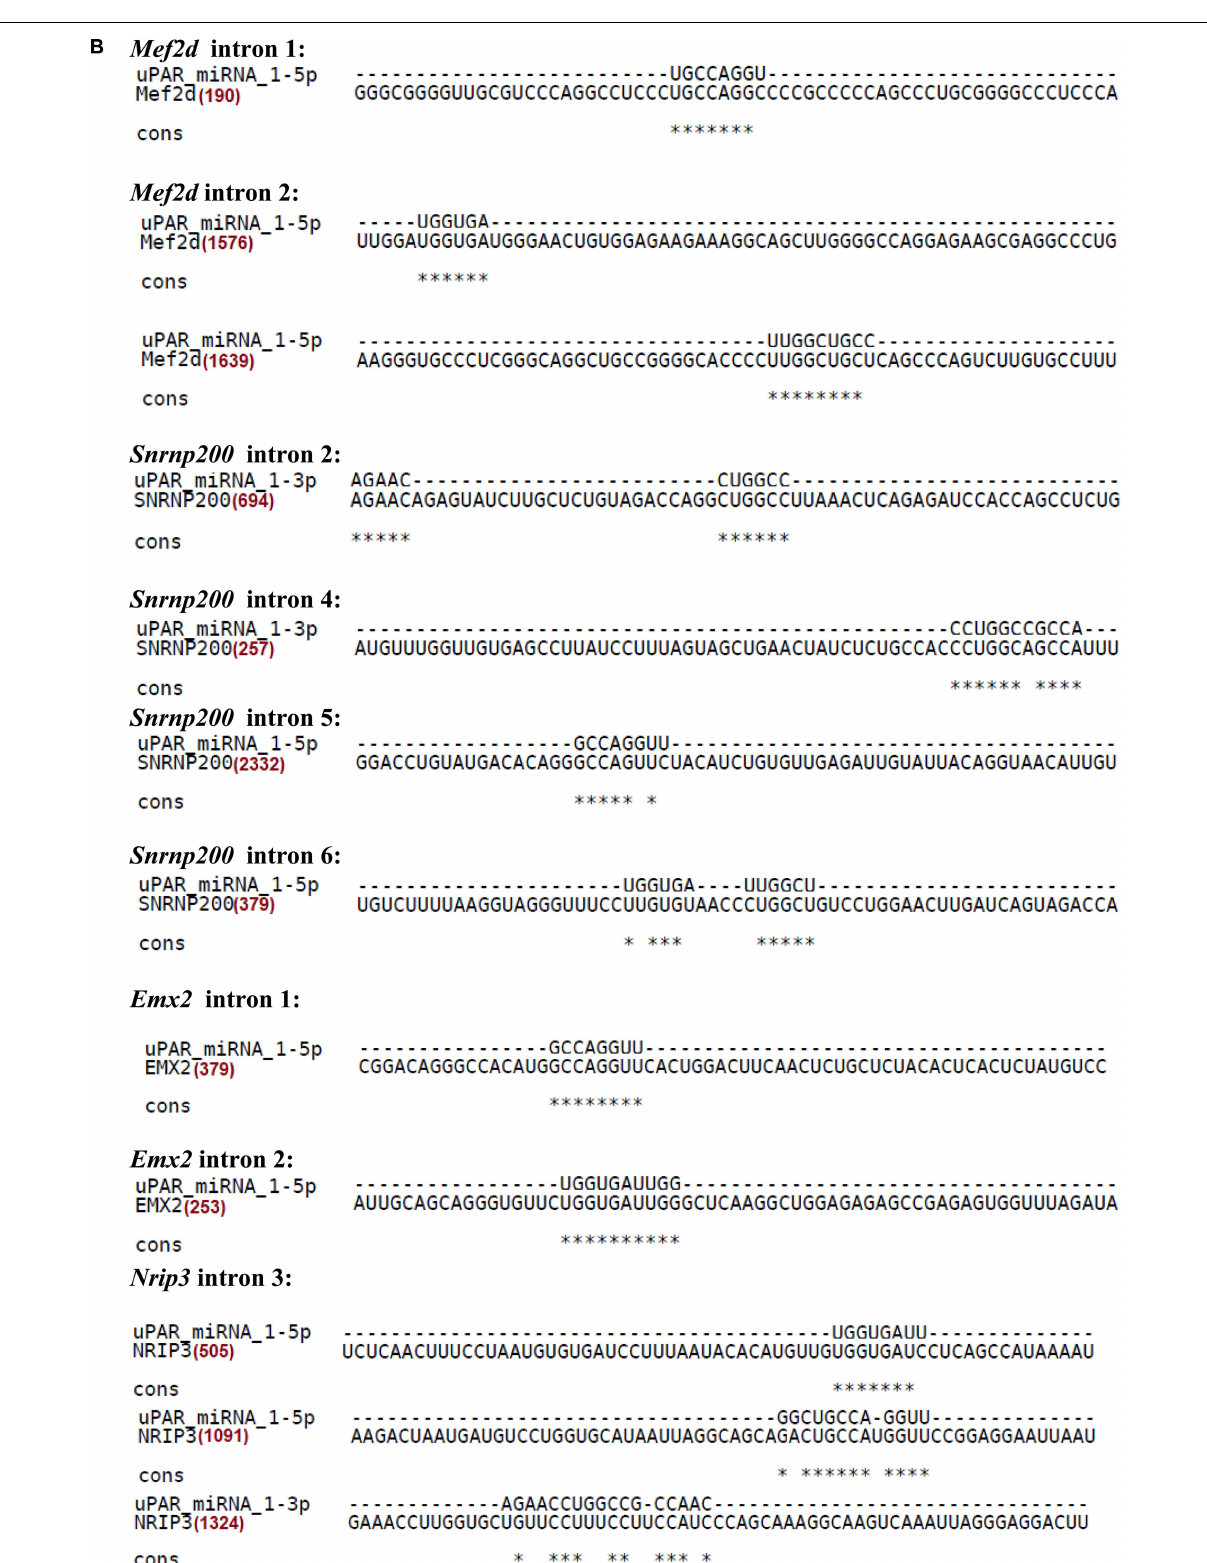
FIGURE 3 | Alignment of Plaur-miR1-5p (A) and Plaur-miR1-3p (B) with promoter regions and introns of the predicted target genes Mef2d , Emx2 , Snrnp200, and Nrip3 with the M-coffee web service T-COFFEE Multiple Sequence Alignment Server.